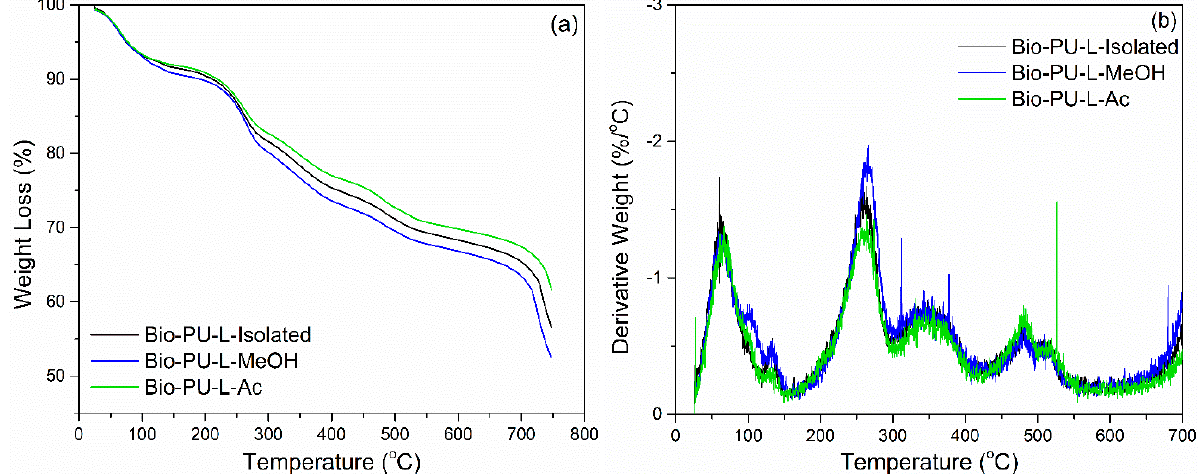
Figure 10. Thermal degradation of Bio ‐ PU resin derived from lignin: ( a ) TGA, ( b ) DTG. The weight residue after heating at 750 °C of each Bio ‐ PU resin (L ‐ Isolated, L ‐ MeOH, and L ‐ Ac) was in the range of 52–61% (Figure 10). Bio ‐ PU L ‐ Ac had the highest weight